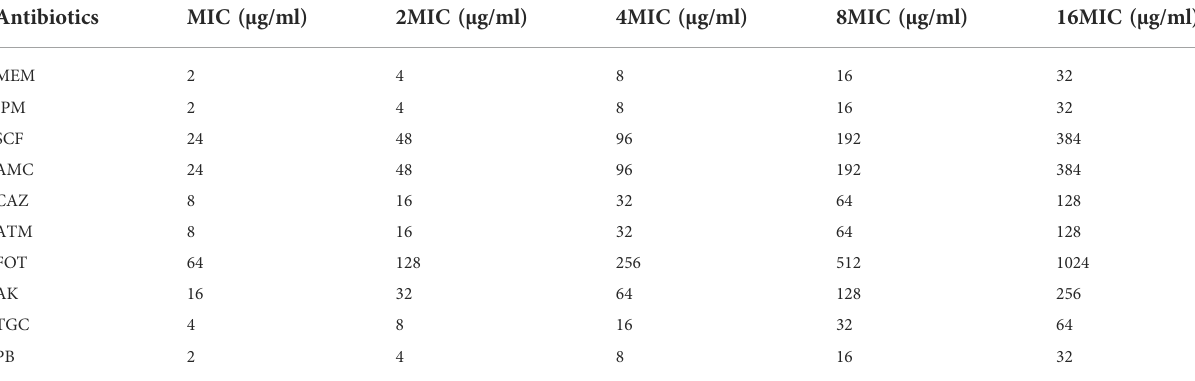
TABLE 1 Concentrations of 10 different antimicrobial drugs used for drug sensitivity testing.